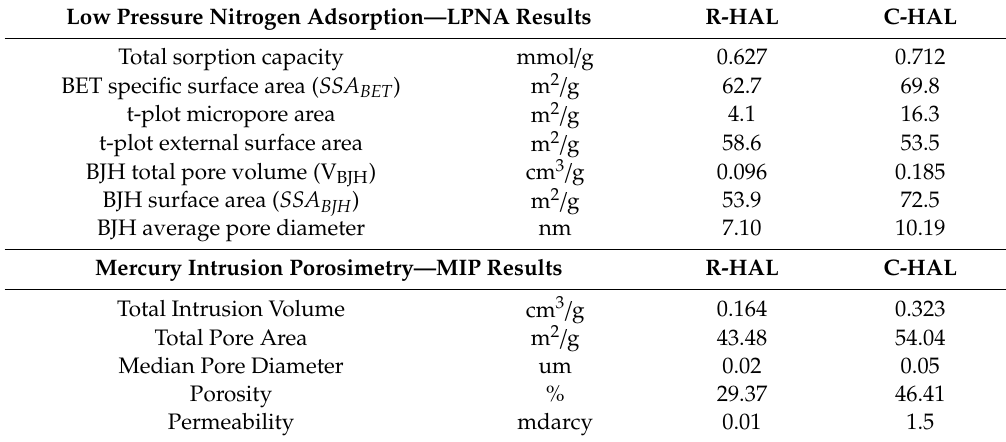
Table 3. Structural parameters of halloysite (LPNA and MIP method).